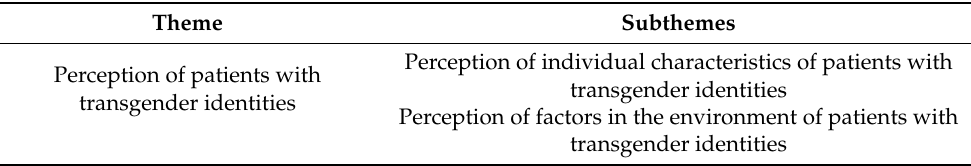
Table 2. Perception of patients with transgender identities.